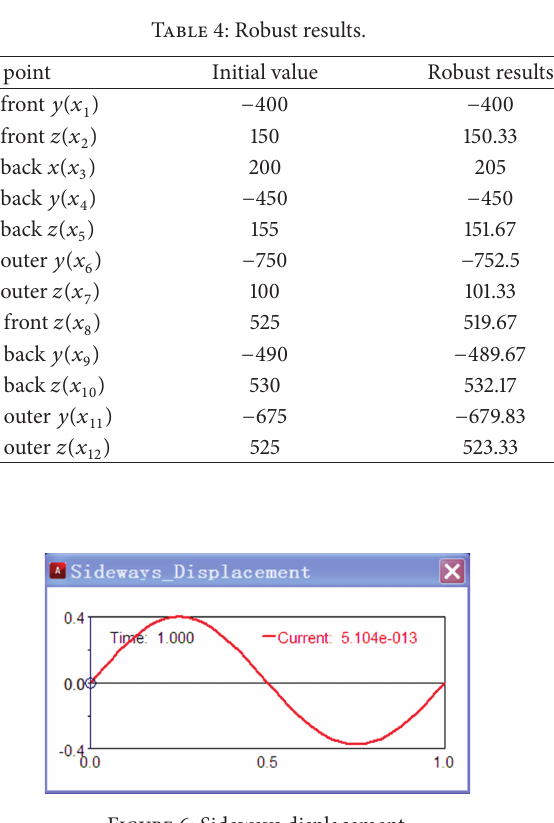
Figure 6: Sideways